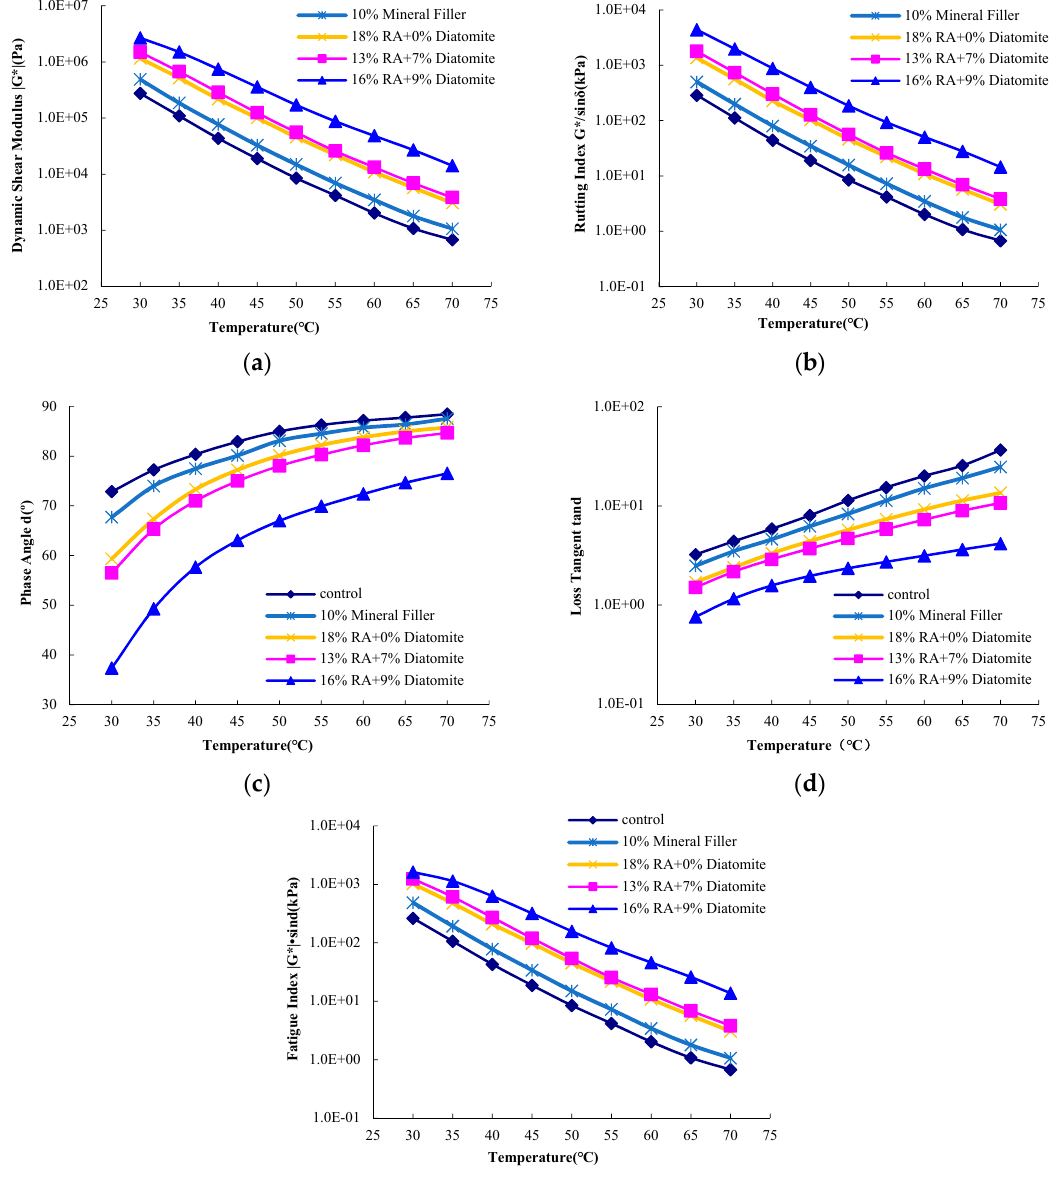
Figure 3. The temperature sweep results: ( a ) dynamic shear modulus; ( b ) rutting index; ( c ) phase angle; ( d ) loss tangent; and ( e ) fatigue index.